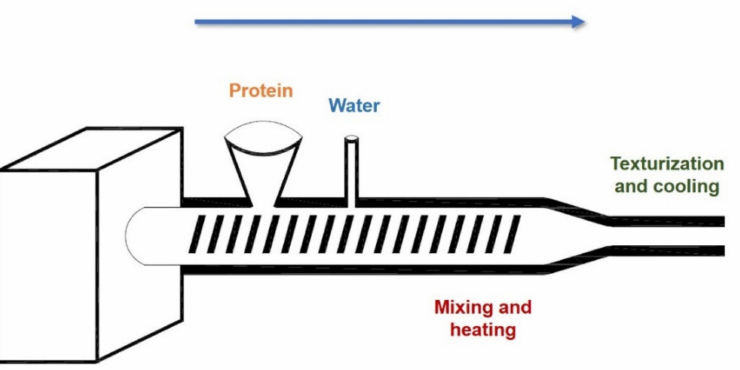
Figure 1. Process of texturization of proteins for application in meat analog